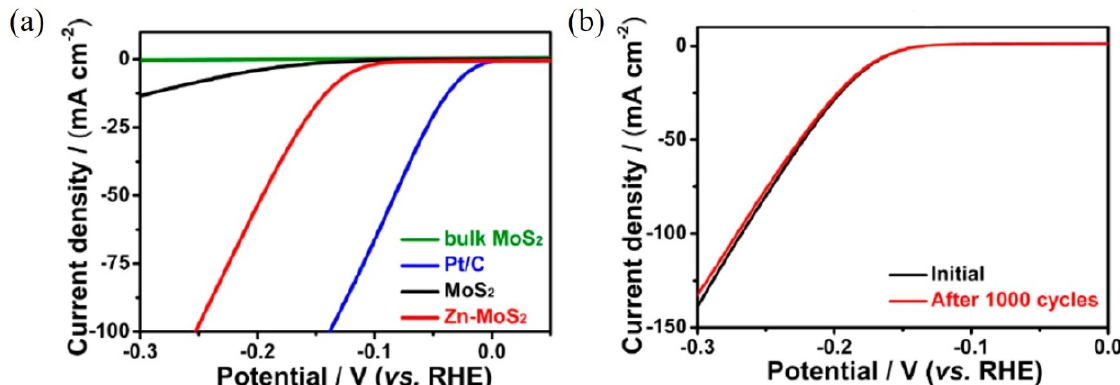
Figure 9. ( a ) Polarization curves of HER for bulk MoS 2 , Pt/C, pure MoS 2 , and Zn-MoS 2 . ( b ) The polarization stability tests of Zn-MoS 2 catalyst (black line: Initial state; red line: After 1000 cycles) [27].